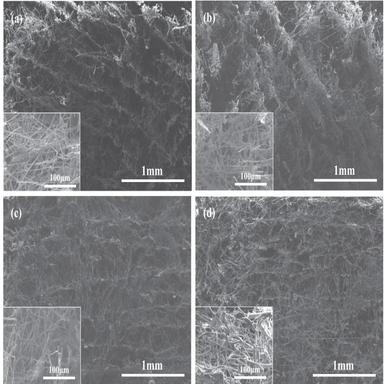
Microstructures of the PFMs with different densities: (a) S1, (b) S2, (c) S3, (d) S4.